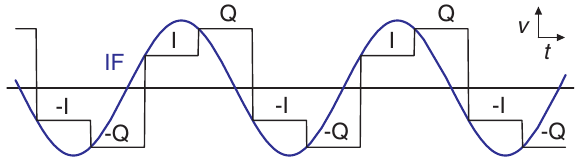
FIG. 5. (Color) Scheme of the ‘‘digital IQ detection,’’ presently used at FLASH: Sampling the intermediate frequency with a four times higher sampling rate yields the vector components of the angular pointer with positive and negative sign.